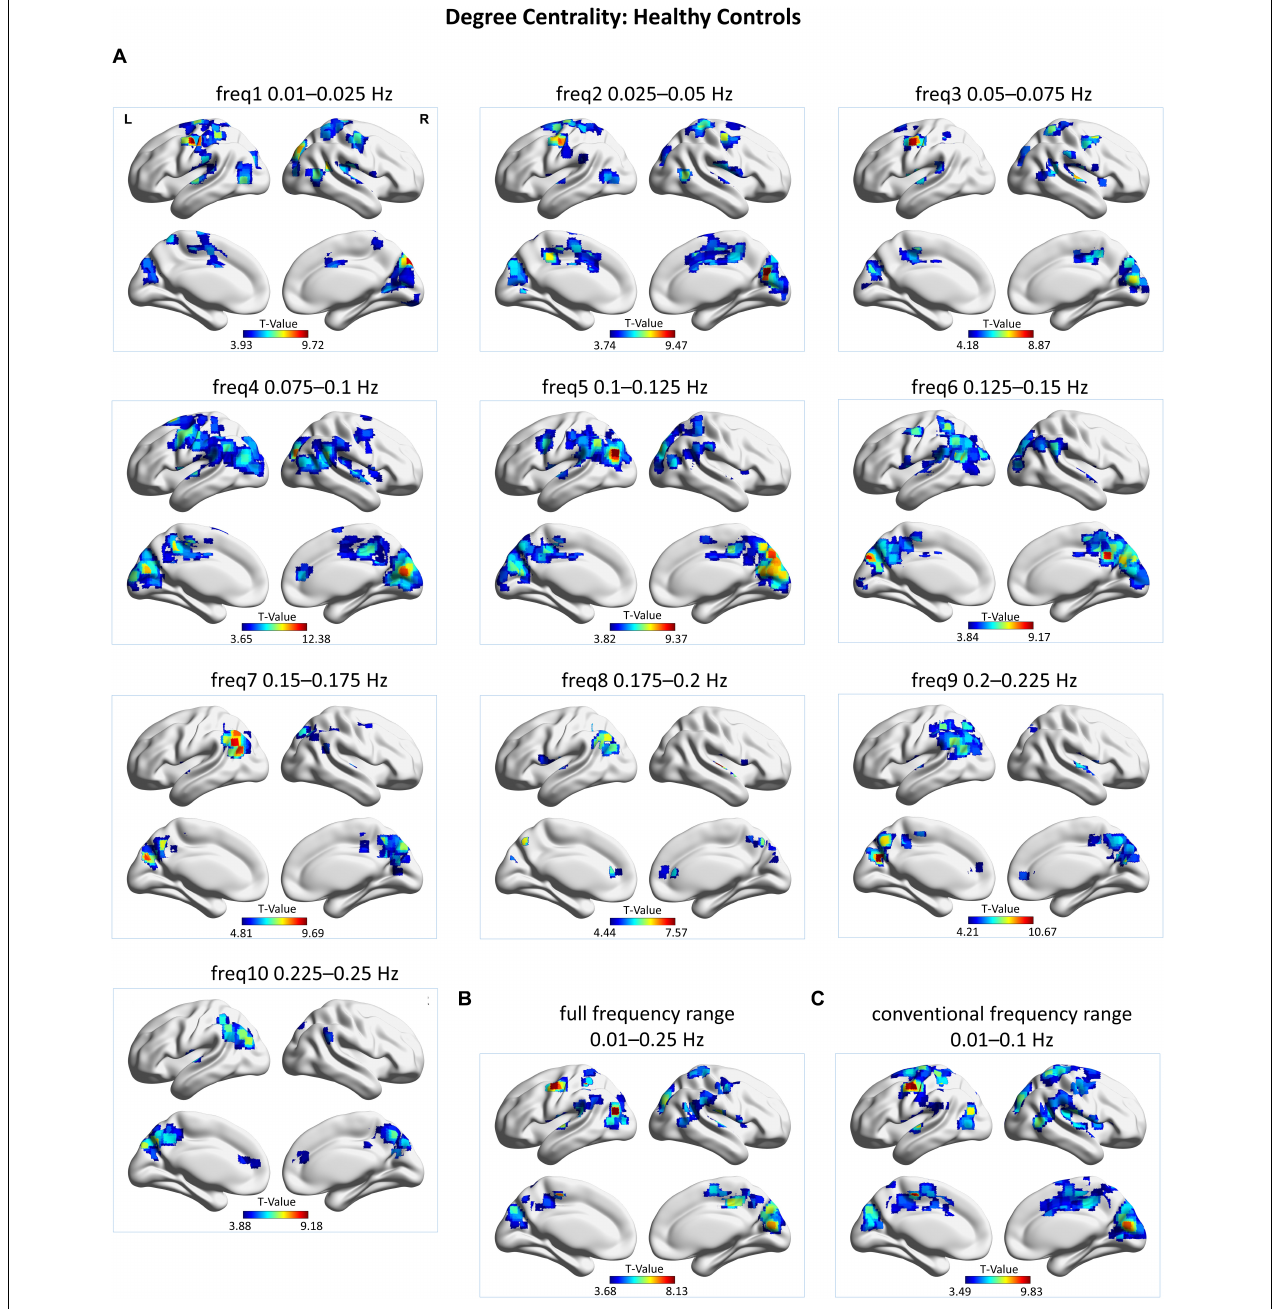
FIGURE 1 | Group-level voxel-wise degree centrality (DC) maps for healthy control (HC) subjects. DC maps were obtained by subjecting individual z-maps to a one-sample t -test ( p cluster-level corrected < 0.05, on underlying voxel-level correction of p < 0.001) with voxels restricted to gray matter. (A) DC maps at 10 different frequency bands, represented by t -values. (B) DC map at the full frequency range of 0.01–0.25 Hz, represented by t -values. (C) DC map at the conventional frequency range of 0.01–0.1 Hz, represented by t -values. L = left, R = right. DC clusters were visualized with the BrainNet Viewer (http://www.nitrc.org/projects/bnv/; Xia et al.,